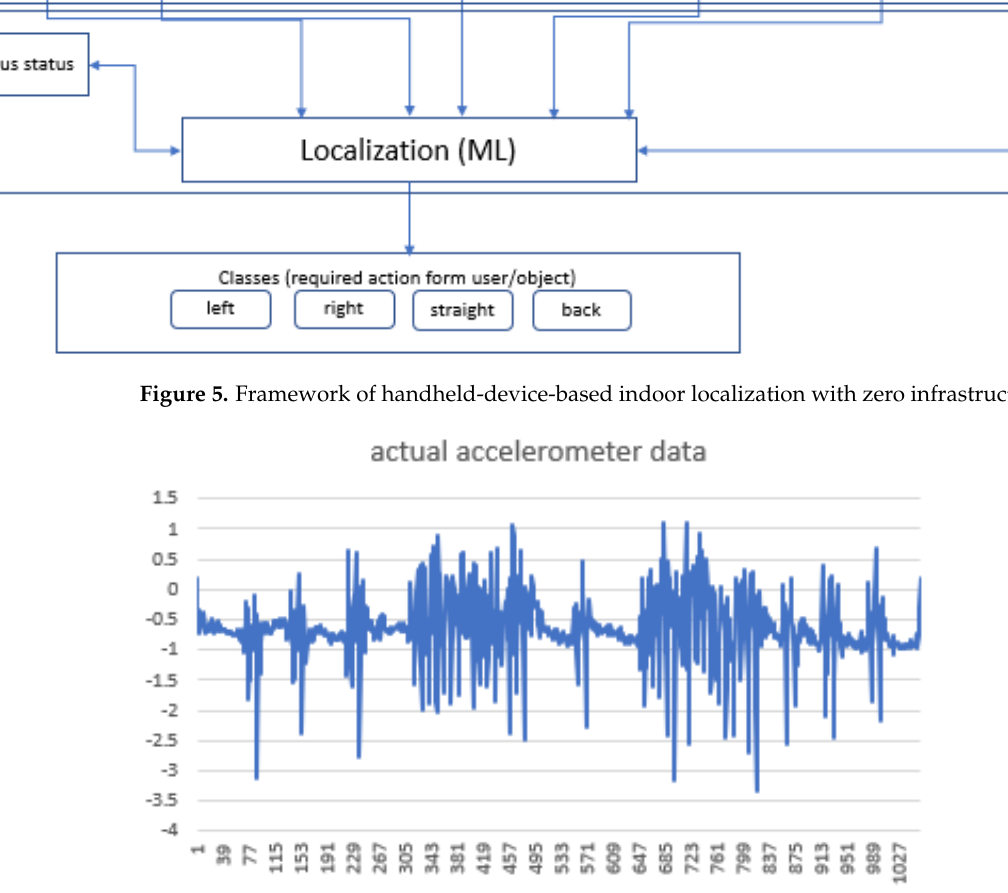
Figure 7. Exponential smoothing result. Before we feed the data into the ML algorithm, it must be reshaped in such a way that each user has multiple two-dimensional records with a number of slices for each of the three axes of the three sensors (i.e., accelerometer, gyroscope, and magnetometer), and each record is given one label (e.g., straight). These records are then input into the ML algorithm during training. Different smoothing filters — such as simple average smooth- ing, equally weighted moving average, or exponential smoothing — have various strengths, such as simplicity, widespread acceptance, and accurate prediction of the nat- ural demand level. The ability to adapt to changes must also be considered, along with accurate reflection of the current conditions and performance in short-term forecasting. Challenges based on the model used include determining optimal smoothing values (i.e., constant weights given to each of the time-series components to make prediction more accurate) and the values of the constants α, β, and ϒ , which are related to the level, trend, and seasonality, respectively (these values always range between 0 and 1 inclusively). Time-series data-based models may not automatically capture events (e.g., walking), as they are not causative modeling techniques and, thus, do not allow explanatory variables, because they are adaptive to changes. Finally, the implementation deeply depends on the SW (e.g., Python, MATLAB, SPSS), and the results may change and require optimization.